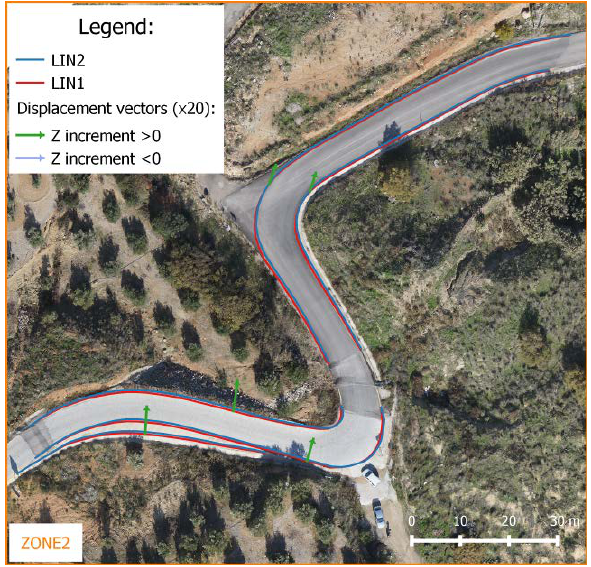
Figure 6. Displacement vectors (20x) from VIM-I in ZONE2.